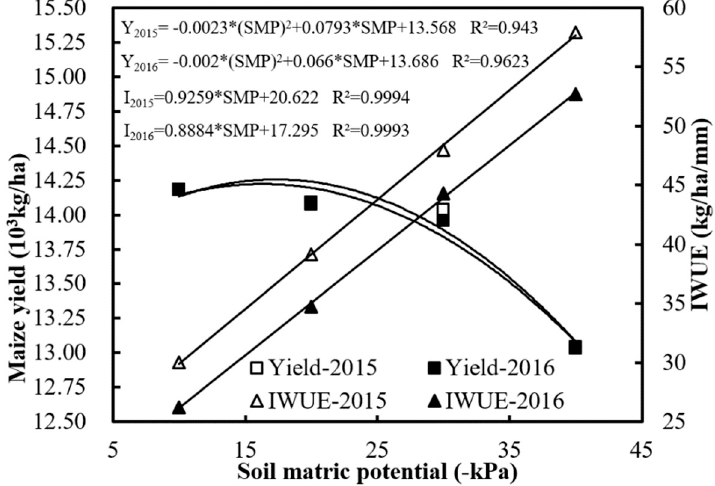
Figure 11. The relationship between maize yield, IWUE, and SMP in 2015 and 2016.